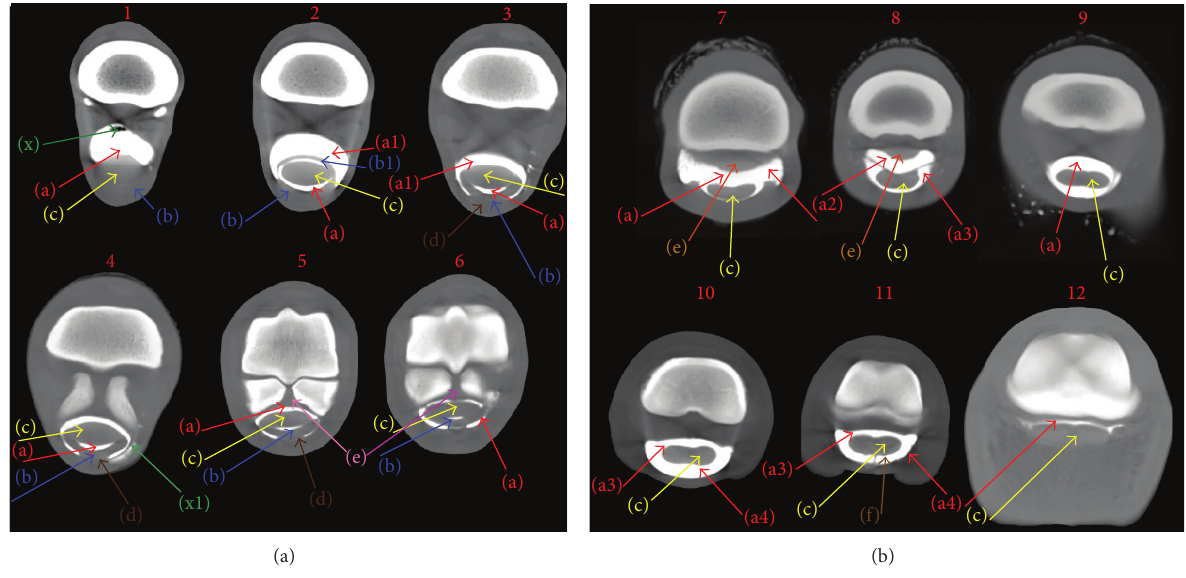
Figure 2: Computed tomographic tenography of ex vivo normal forelimbs of horses: representative images of transverse scans. Scans are shown proximally to distally: scans 1 to 6 of metacarpal region and 7 to 12 of pastern region. (a) Proximal pouch of digital flexor tendon sheath (DFTS) synovial cavity, (a1) palmar aspect of DFTS synovial cavity, (a2) synovial collateral recess, (a3) distal synovial fold, (a4) dorsal distal recess of DFTS, (b) superficial digital flexor tendon (SDFT), (b1) manica flexoria, (c) deep digital flexor tendon (DDFT), (d) mesotendon, (e) intersesamoidean ligament, (f) straight sesamoidean ligament, (g) mesotendon, (x) artefact and air bubbles, and (x1) subcutaneous contrast medium (CM) outflow after injection.